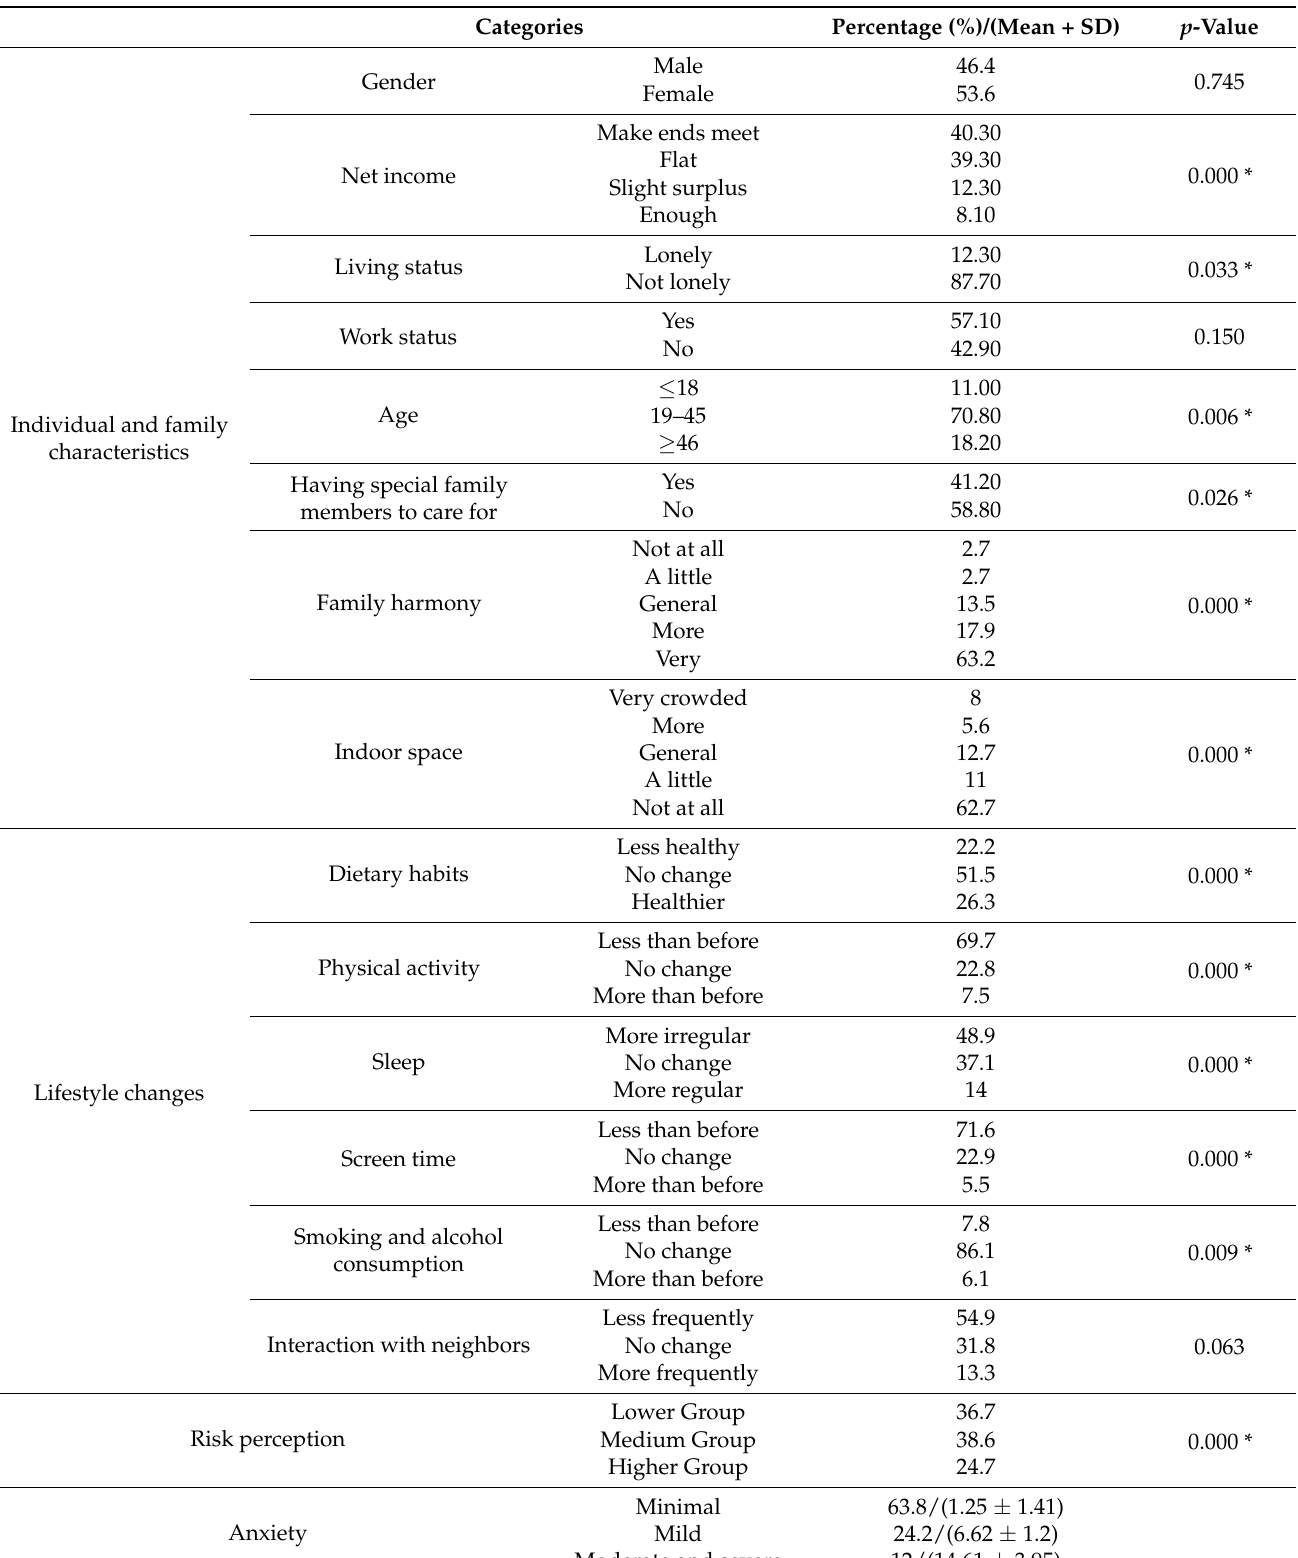
Table 1. Descriptive analysis and non-parametric test of